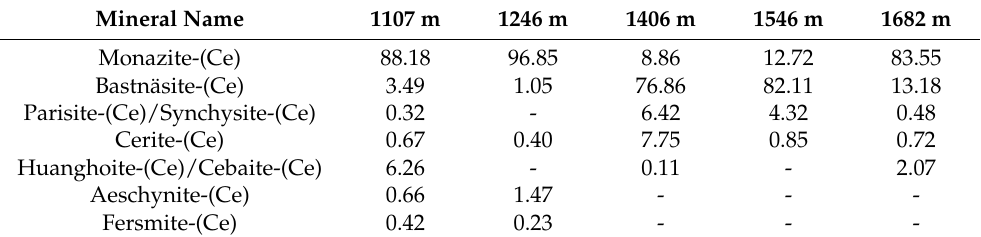
Table 2. Summary of Ce deportment of the Bayan Obo drill core samples from different depths given by TIMA analysis (wt.